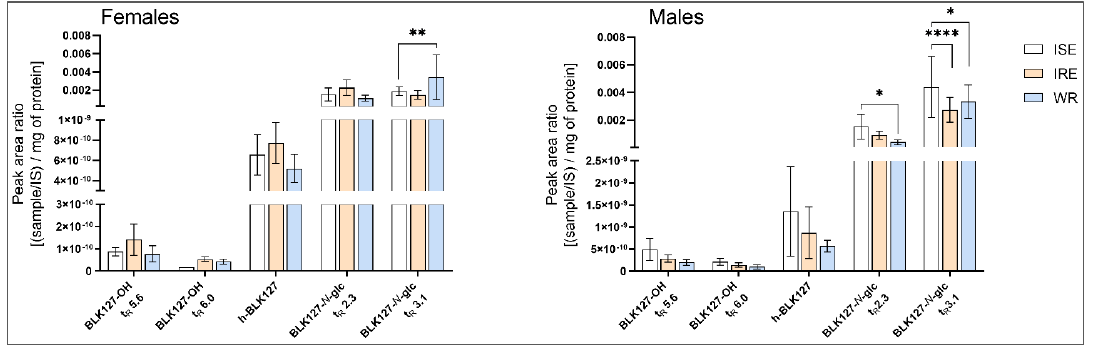
Figure 6. The amounts of compound BLK127 metabolites formed in adults of H. contortus from ISE, IRE and WR strains. Semi-quantification was performed using the peak area ratio normalized to the total protein amount (mg). Data are presented as means ± SD. For statistical analysis, two-way ANOVA with Tukey’s multiple comparisons test was used. *, p < 0.05; **, p < 0.01; **** p < 0.0001. The proposed metabolic pathways are presented in Figure 7.